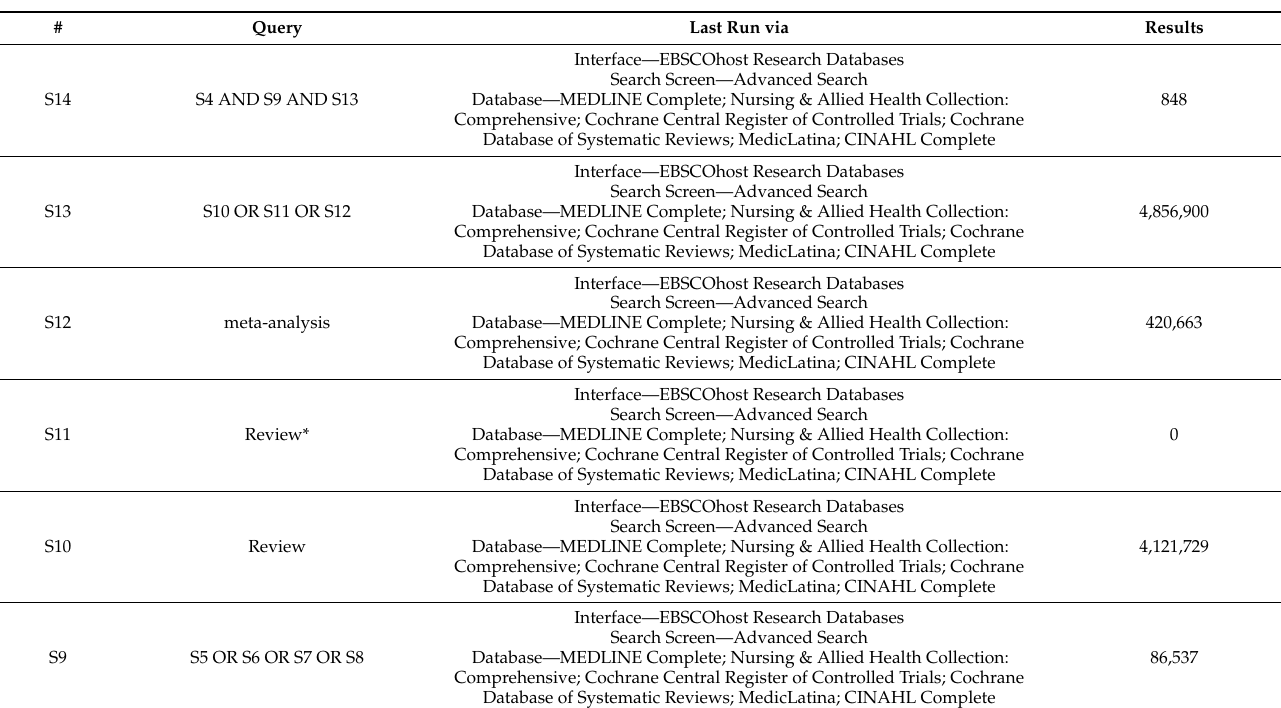
Table A3. EBSCOhost research